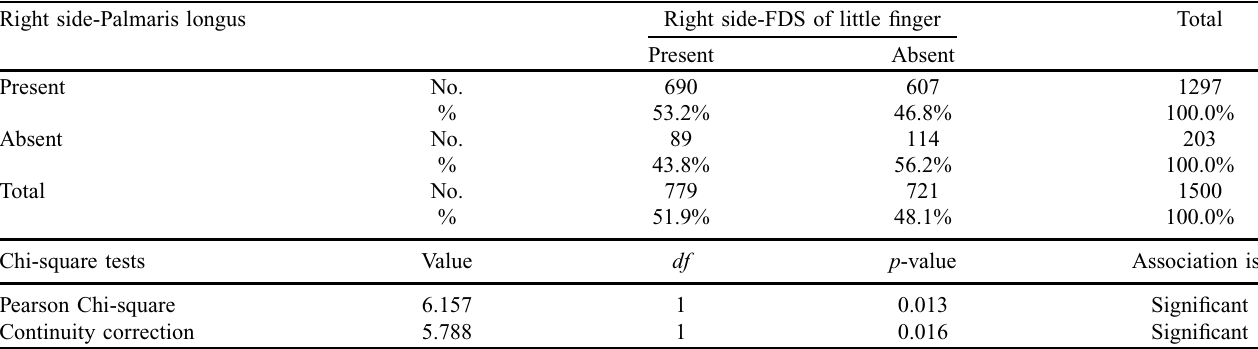
Significant association between right side palmaris longus and right side flexor digitorum superficialis* of the little finger. p -value = .013 (<.05). Table 2. Association among the cases between left side-palmaris longus and left side-FDS* of little finger. Left side-Palmaris longus Present